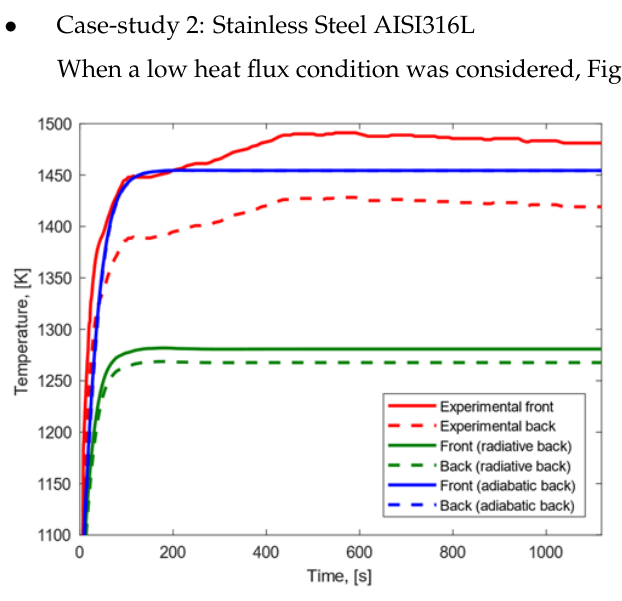
Figure 9. Experimental and modeling temperature profiles for stainless steel AISI316L subjected to low heat flux.